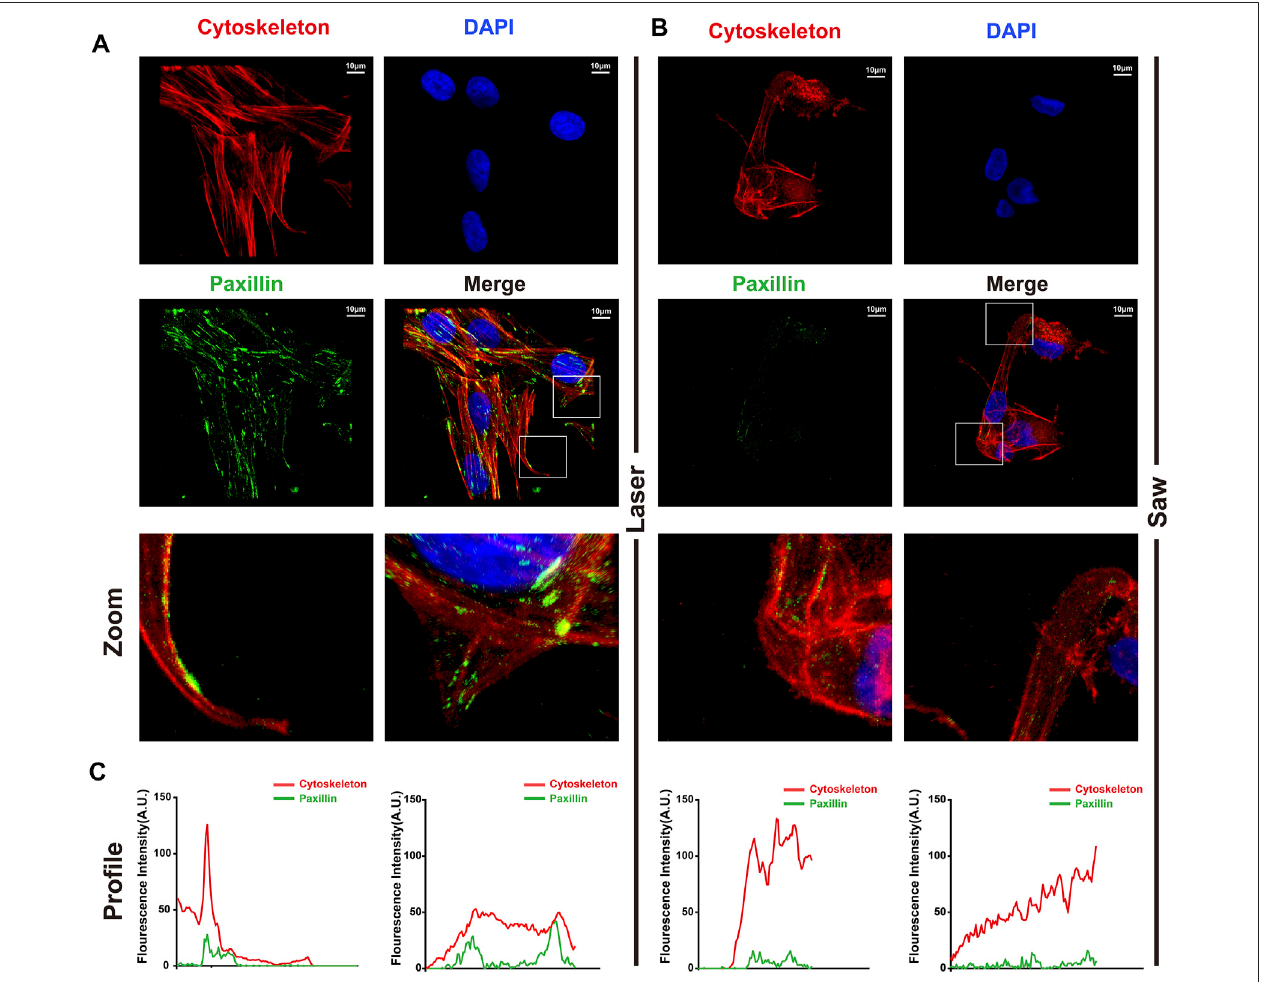
FIGURE 8 | Typical images of laser cutting bone surface promoting the formation of focal adhesion. (A) The laser group and (B) the mechanical saw group were photographed by laser confocal microscope. The red is the cytoskeleton, the green is the paxillin, and the blue is the nucleus. (C) Pro fi les of F-actin (red) and p-paxilin (green) were extracted from images (white segments) using ImageJ